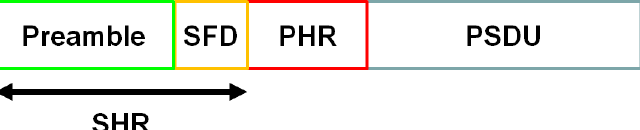
Figure 1. Ultra-wideband physical layer frame format. SFD, SHR, PHR, and PSUD are abbreviations of start-of-frame delimiter, synchronization header, physical layer header, and physical layer service data unit